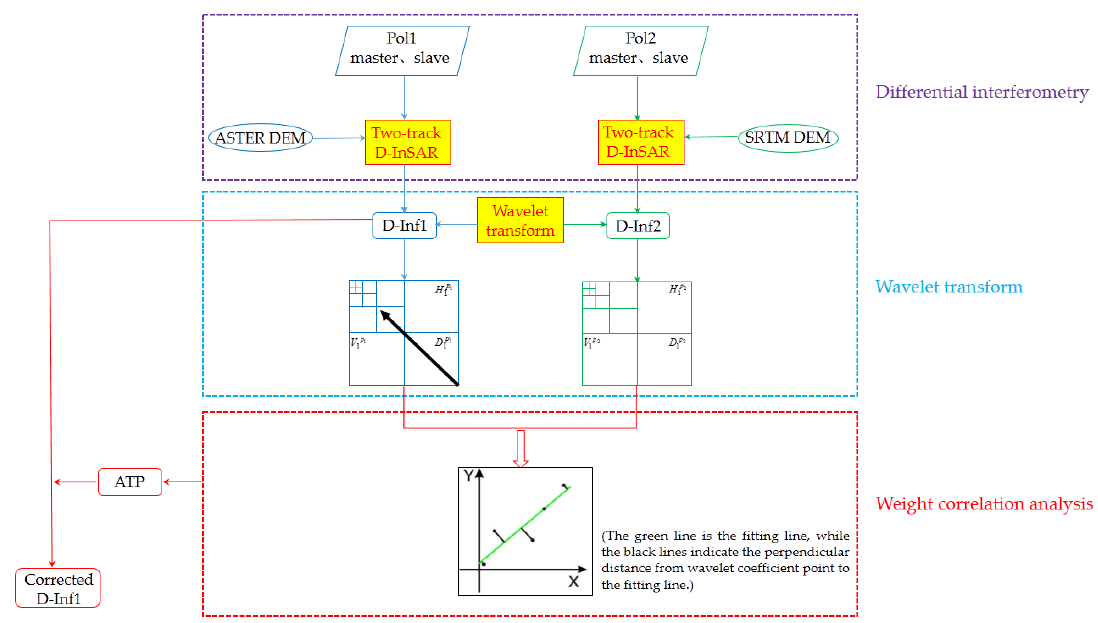
Figure 1. The workflow of the multi-resolution weighted correlation analysis (MRWCA) method.